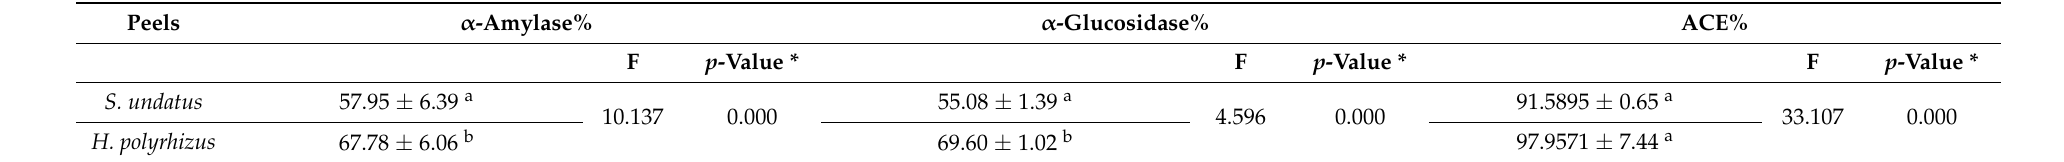
Table 4. Biological activity of secondary metabolites in methanol extracts in melissa, peppermint, thyme, and